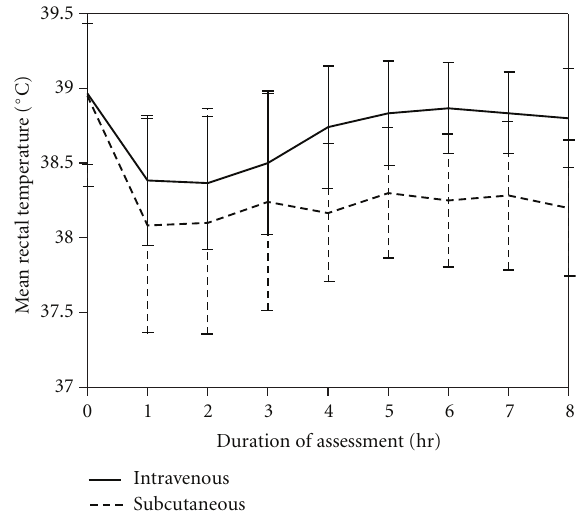
Figure 1: Mean respiratory rates over time for the IV and SC groups (IV group, P = 0 . 069; SC group, P = 0 . 904).